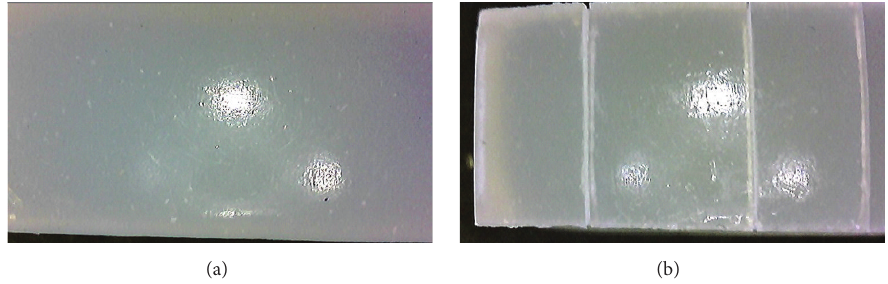
Figure 10: 42-day irradiated specimens after tensile tests. (a) Neat UHMWPE; (b) UHMWPE with